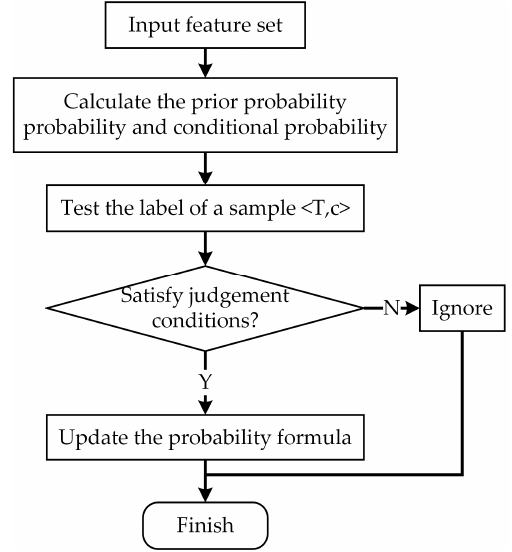
Figure 6. Flow chart of Bayesian incremental learning.